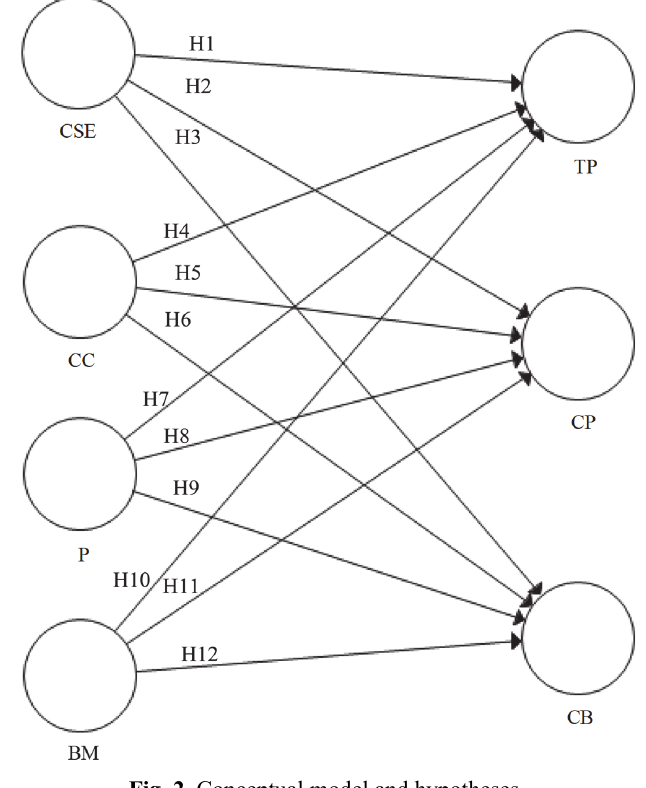
Fig. 2. Conceptual model and